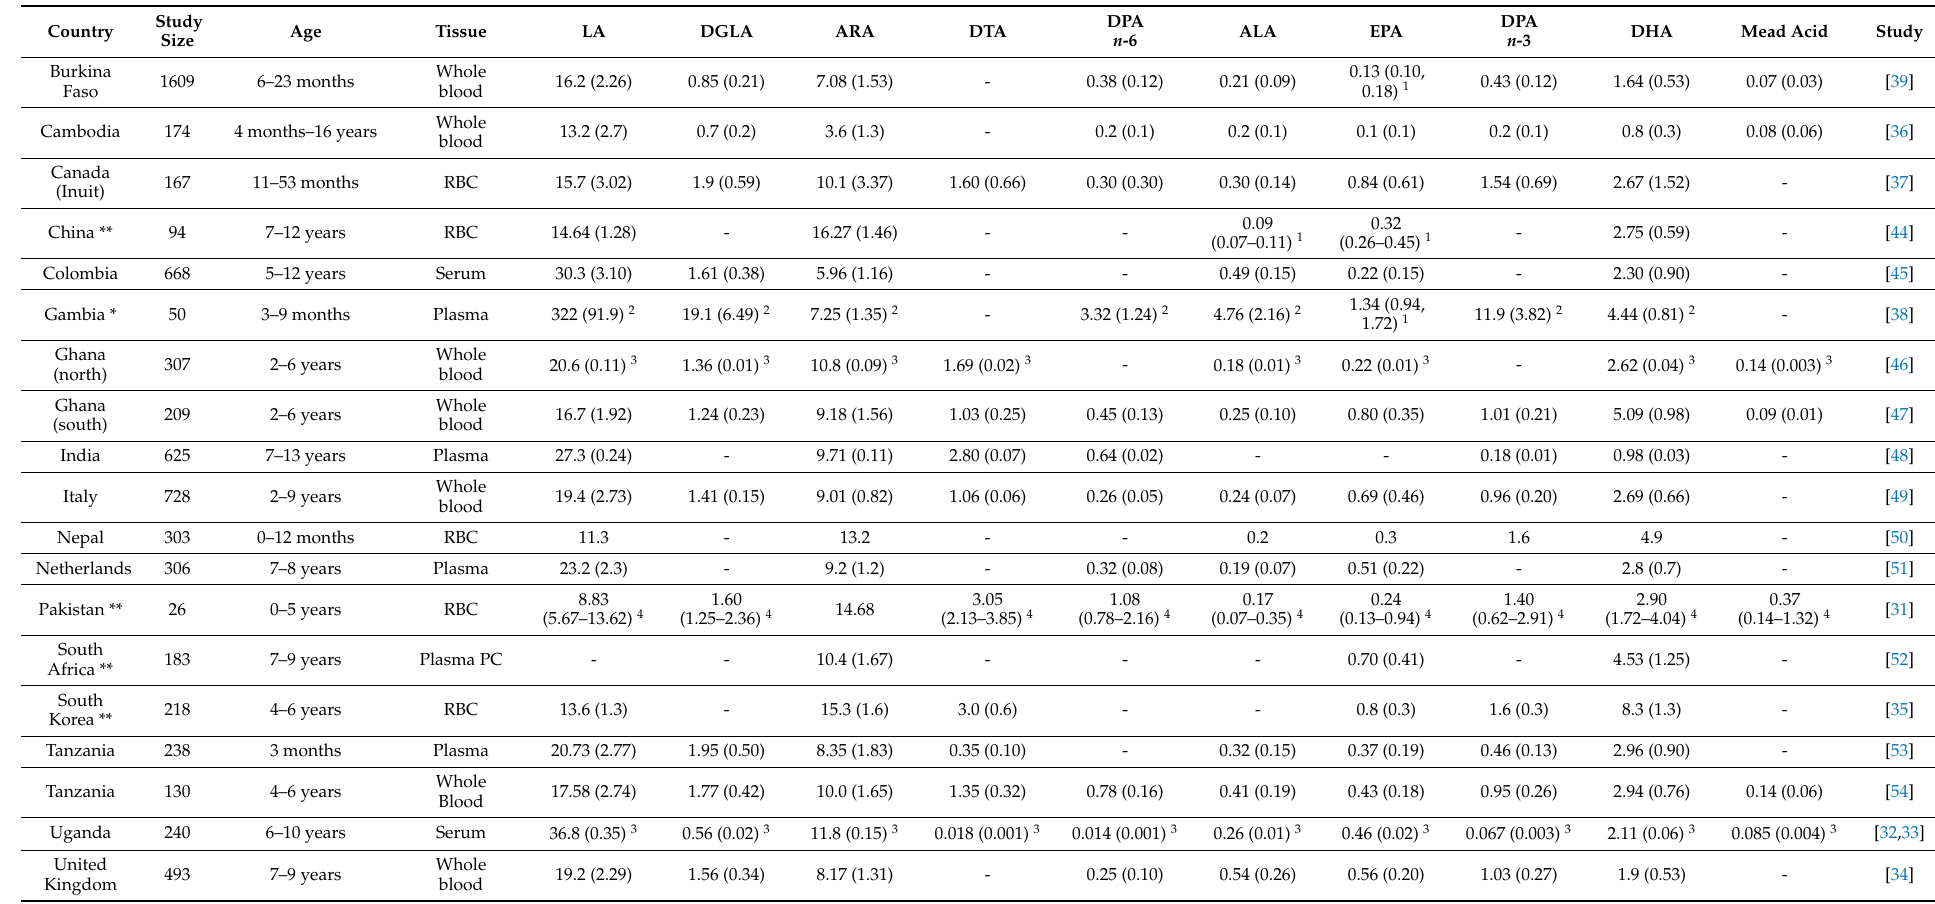
Table 1. Variation in select blood polyunsaturated fatty acid levels among child populations in different countries and